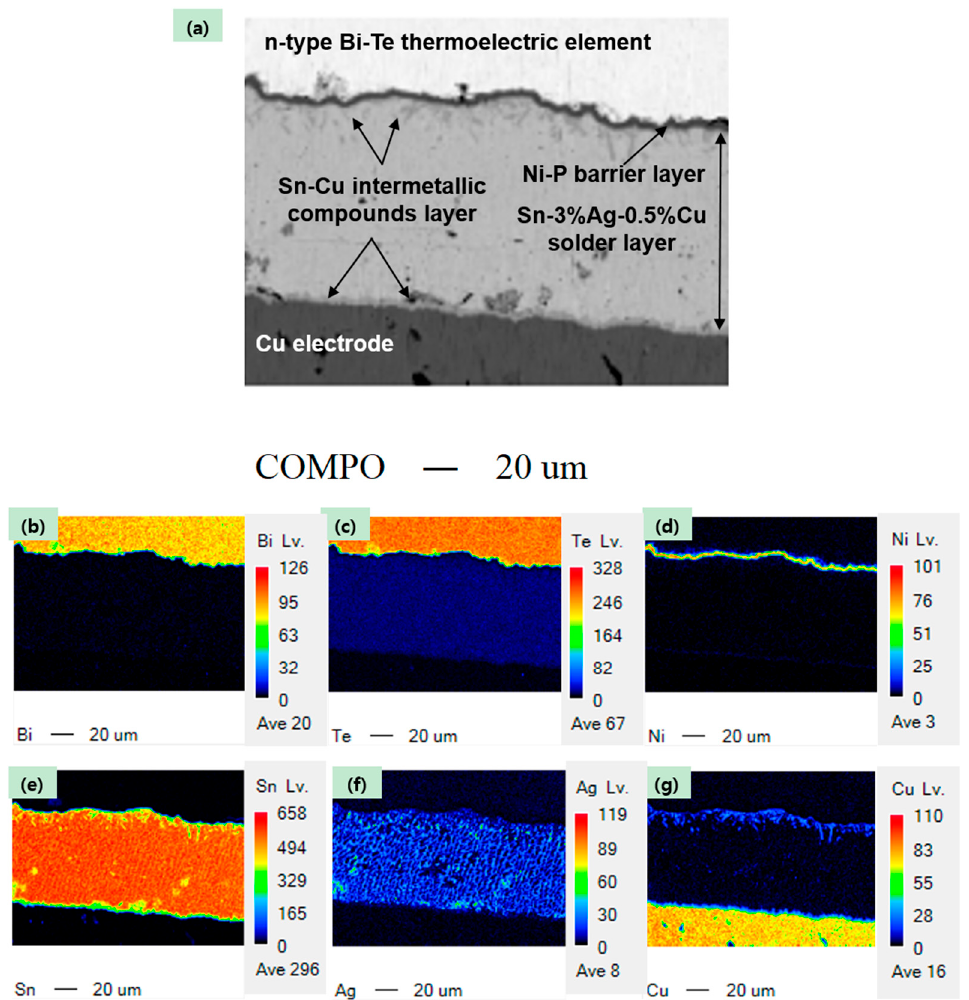
Figure 5. Bonding interface between the solder and n-type thermoelectric element with electroless Ni–P plating observed using field emission electron probe microanalysis (FE-EPMA). ( a ) BSE image; ( b ) Bi element map; ( c ) Te element map; ( d ) Ni element map; ( e ) Sn element map; ( f ) Ag element map; and ( g ) Cu element map. Coatings 2018 , 8 , x FOR PEER REVIEW